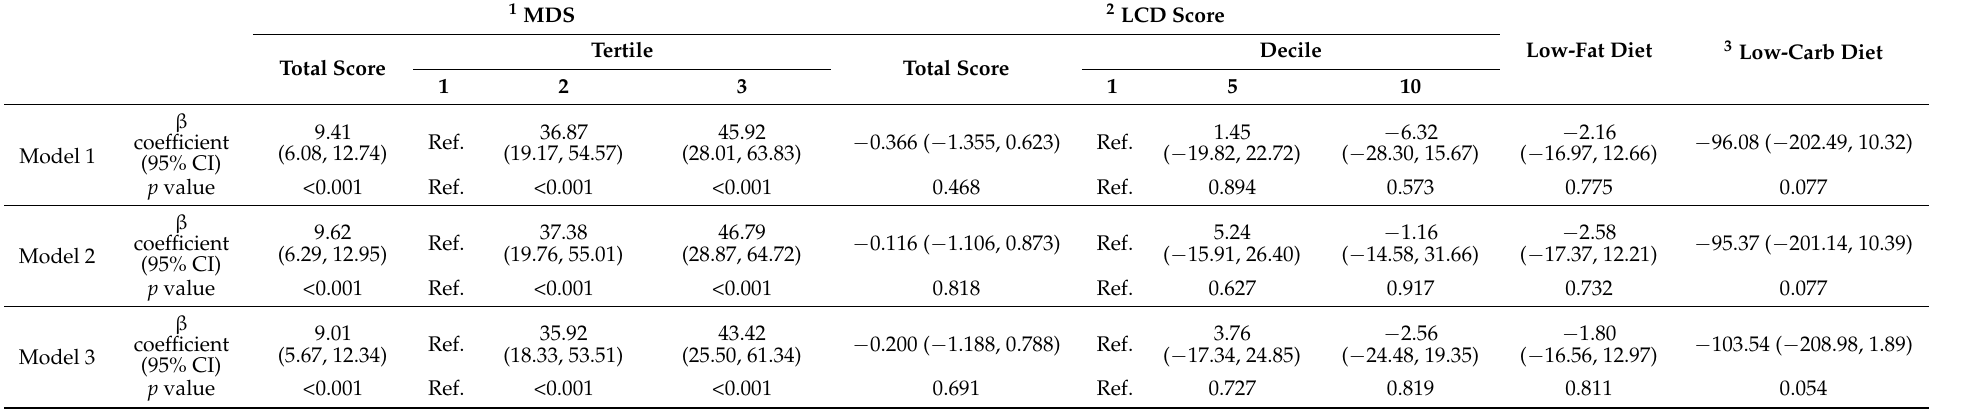
Table 2. Linear regression analyses for the associations between different dietary patterns and serum klotho levels.